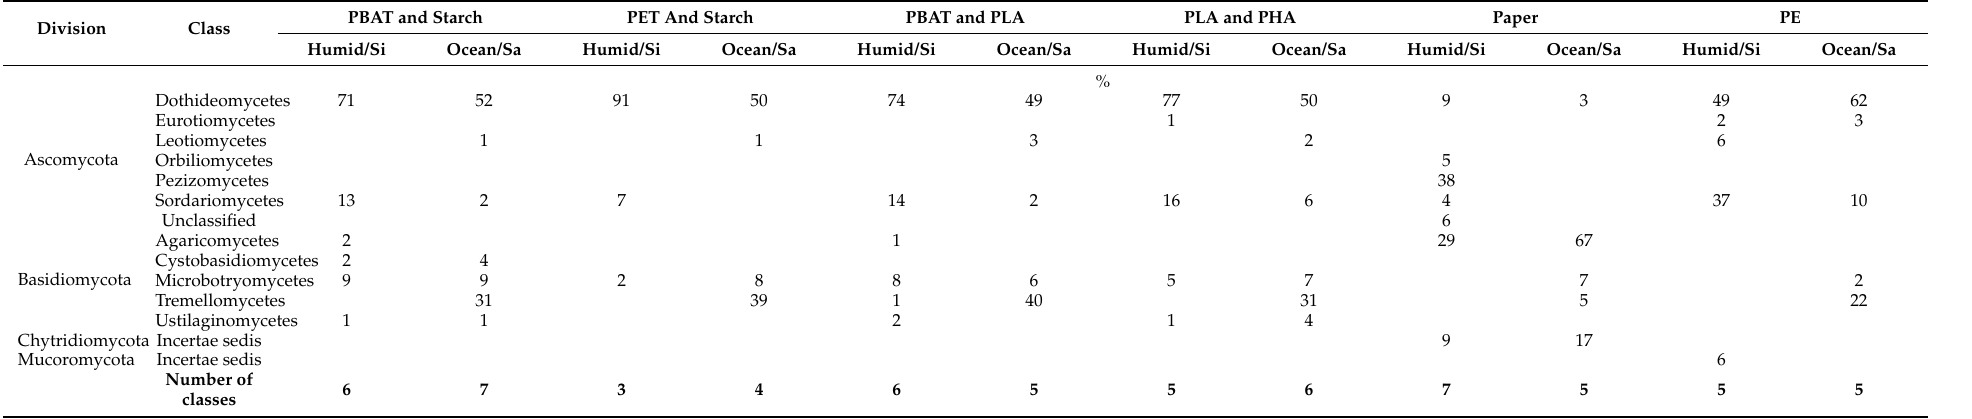
Table 5. Populations of fungi, expressed as percentages and divided by classes, found on different mulches and in two locations. Humid/Si: location with humid subtropical climate (Cfa, according to the Köppen classification) and silt loam soil. Ocean/Sa: location with temperate oceanic climate (Cfb, according to the Köppen classification) and sandy loam soil. Values below 1% were excluded. Adapted from Bandopadhyay et al.